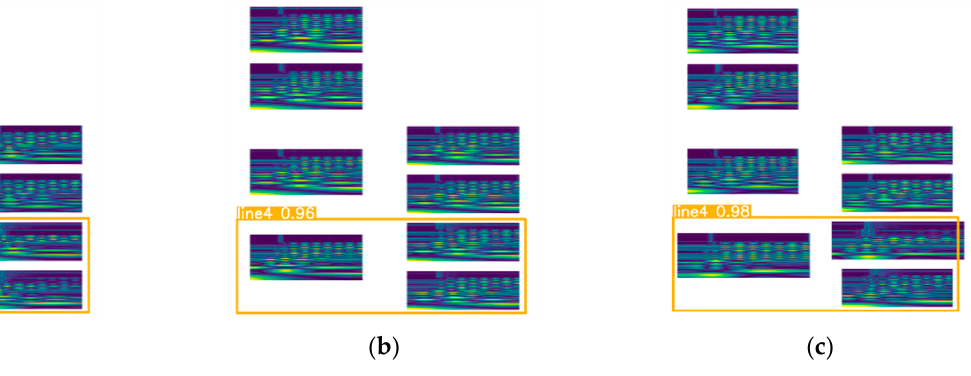
Figure 19. Grounding fault that occurred in Line 4: fault phase of ( a ) A; ( b ) B; ( c ) C.